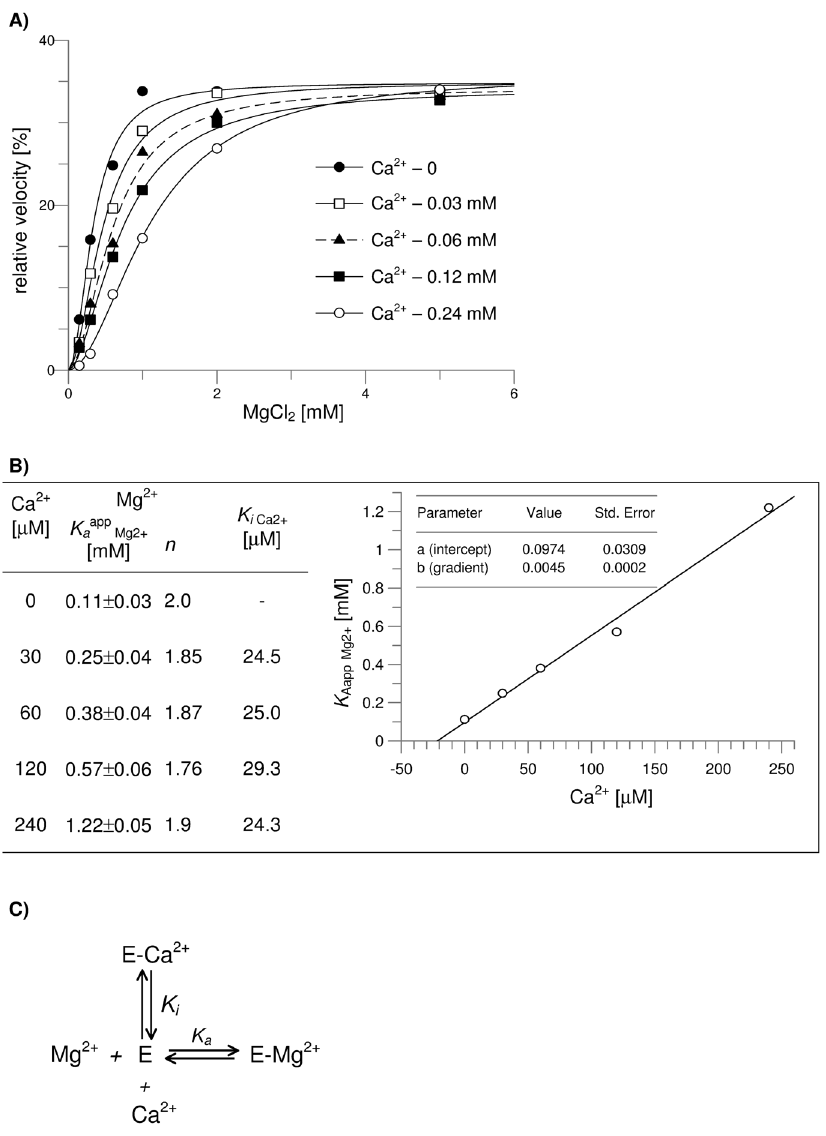
Figure 1. The effect of Ca 2 + on kinetic parameters of wild-type and mutated form of muscle FBPase. A) Activation of the Tyr 57 Trp muscle FBPase mutant by Mg 2 + in the presence of various concentrations of calcium. B) Calcium-induced increase in apparent dissociation constant for Mg 2 + ( K a app Mg2 + ) does not affect the value of dissociation constant for Ca 2 + ( K i Ca2 + ). Hill constant ( n ) is given for the activation by Mg 2 + . The plot shows that the increase in K a app Mg2 + is a linear function of Ca 2 + concentration. The average value of K i for Ca 2 + calculated from the plot ( K i Ca2 + ) equals to 21.65 m M. C) The mechanism that produce competition between magnesium and calcium ions. From this, the equation describing the competitive inhibition is: K i Ca2 z ~ Ca 2 z (cid:1) (cid:2) = K aapp Mg2 z = K a Mg2 z { 1 (cid:3) (cid:4) , where K a app Mg2 + is the apparent activator’s (Mg 2 + ) dissociation constant and K a Mg2 + is the dissociation constant for Mg 2 + as determined in the absence of Ca 2 + .